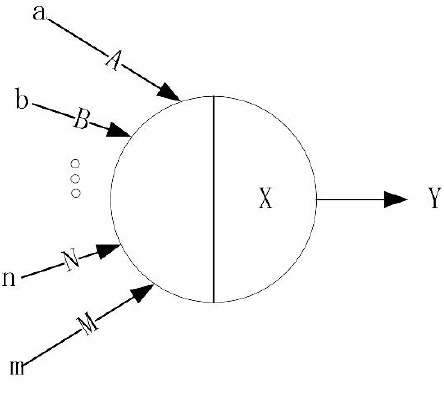
Figure 6. Single neuron model.